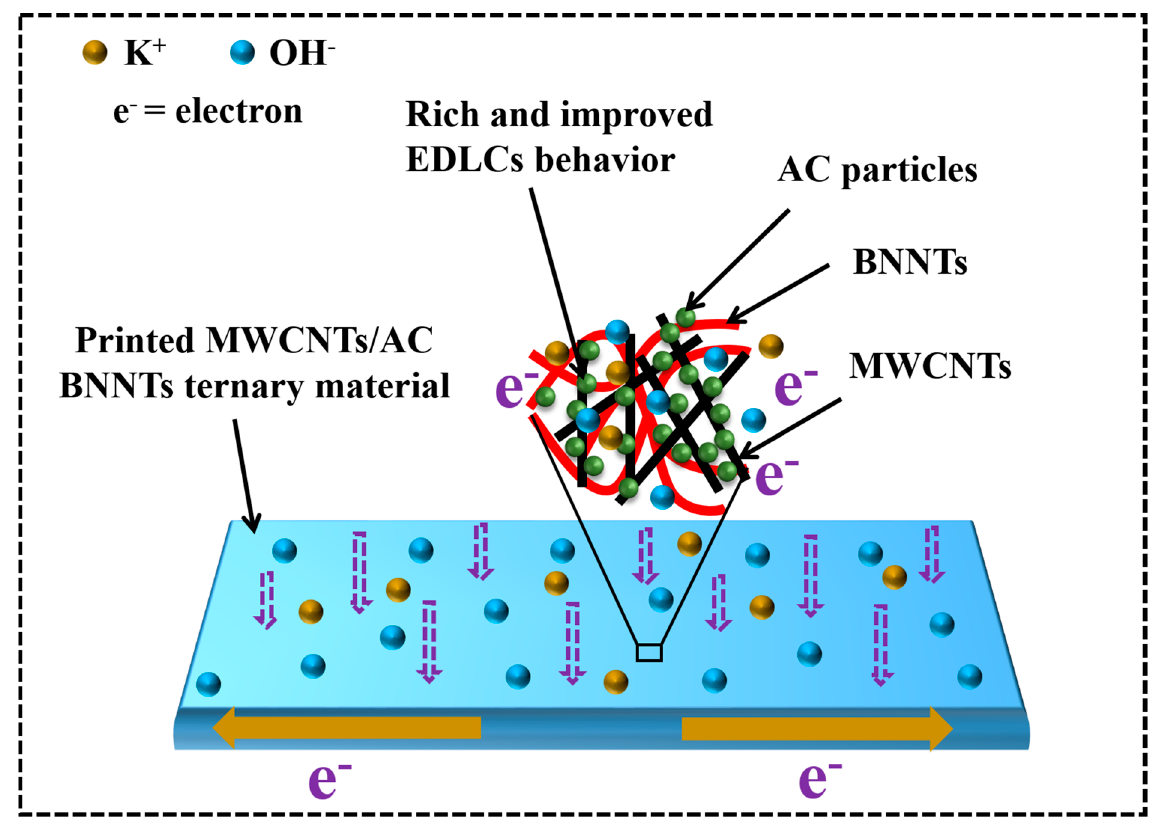
Figure 7. Schematic diagram showing the improved and rich electrical double layer capacitor (EDLC) behavior of the printed MWCNTs/AC/BNNTs ternary composite material.